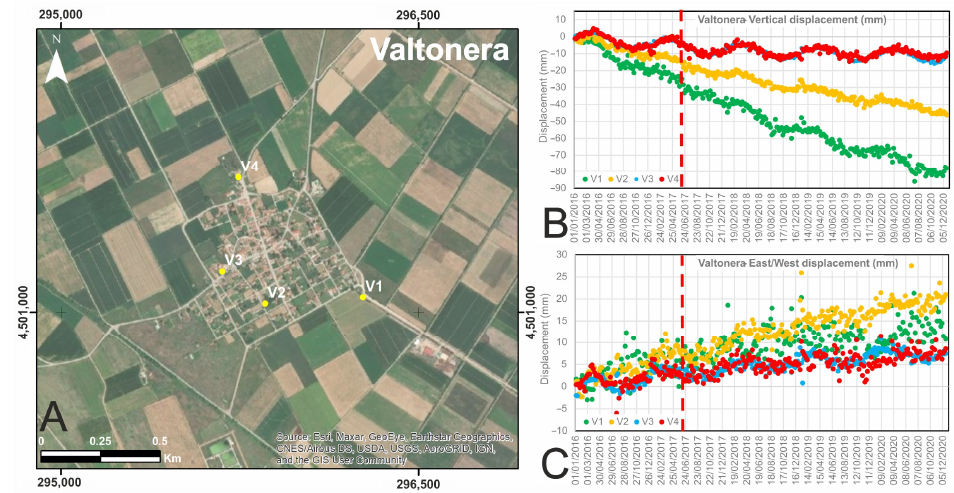
Figure 8. Spatial distribution of examined PS points ( A ) along with their displacement time series ( B , C ) at the village of Valtonera. The dashed line indicates the date of the mining landslide event. The vertical displacements identified at the Fanos village are significantly less intense than those at the Valtonera and Anargiroi villages; nonetheless, this village also suffers from the occurrence of surface ruptures and differential deformation. These deformation types can be attributed to the pronounced stiffness and compressibility differences of the area’s underlying formations, as the northern part of the village overlies Neogene rocks, and the western part overlies Quaternary formations.